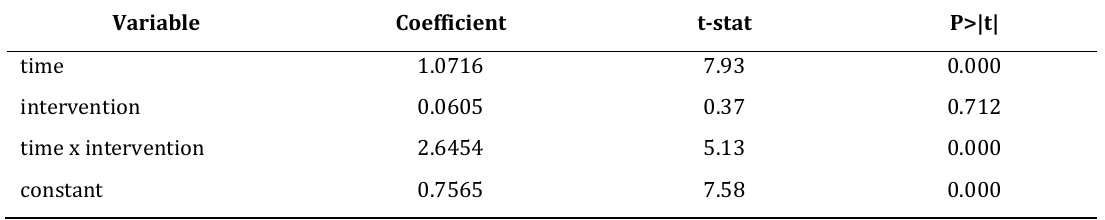
Table 10: The impact of some OECD countries entrance in the EU in terms of FDI with respect to the rest of the OECD countries Variable Coefficient t-stat P>|t| time 1.0716 7.93 0.000 intervention 0.0605 0.37 0.712 time x intervention 2.6454 5.13 0.000 constant 0.7565 7.58